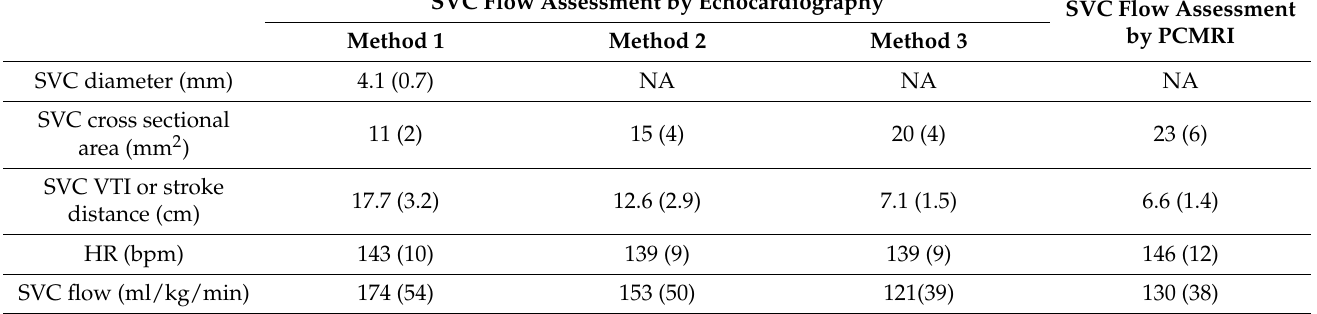
Table 3. Mean (SD) of SVC diameter, SVC area, VTI, HR and SVC flow assessed by ultrasound according to the three methods and PCMRI.